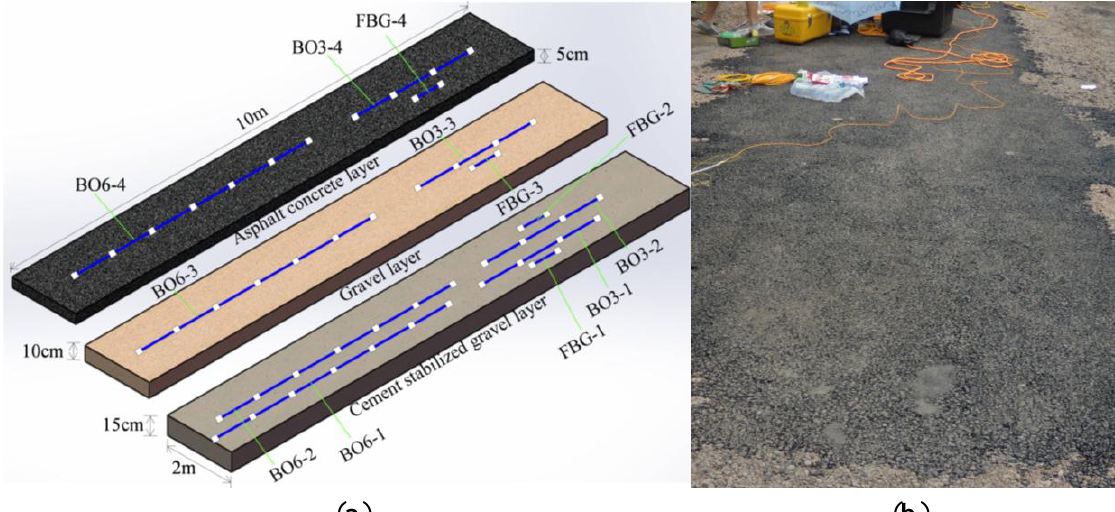
Figure 22. The layout and external view of armoring-wire encapsulated strain sensors